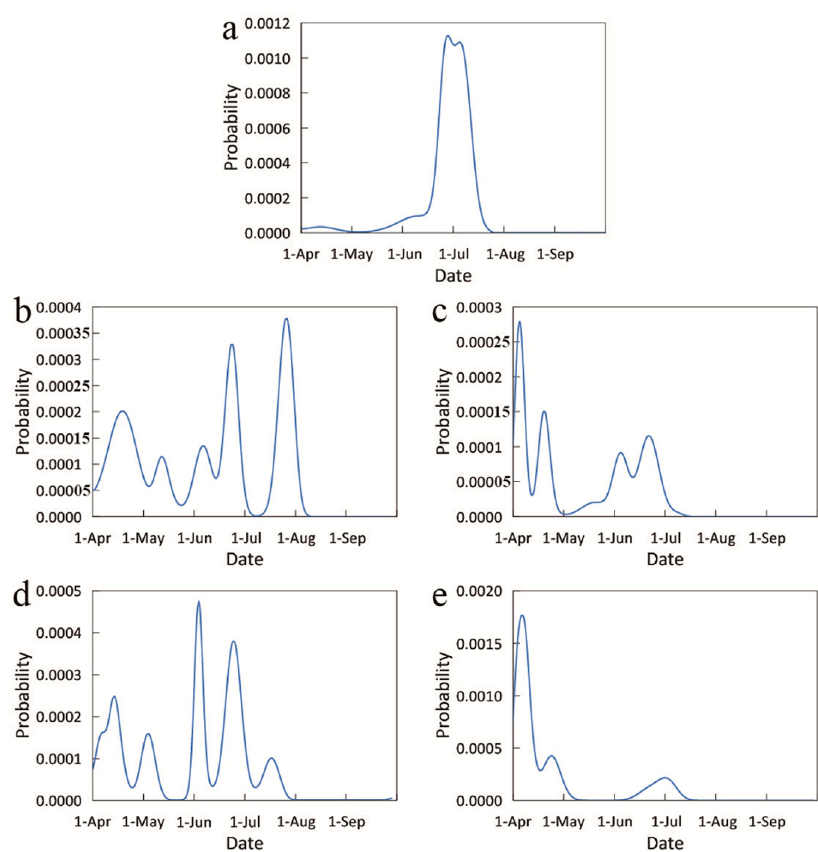
Figure 10. Encounter probability of flood occurrence dates in the flood season. ( a ) The reference